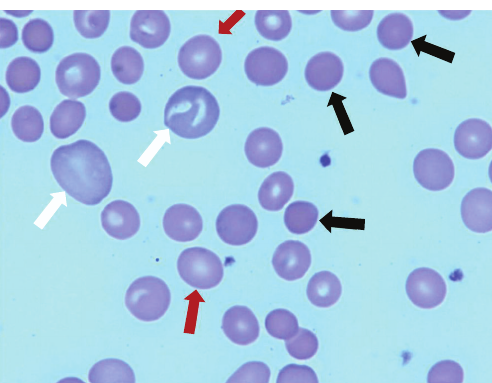
Figure 1: Peripheral blood smear shows microspherocytes (black arrows), polychromasia (white arrows), and normal looking red blood cells with central pallor (red